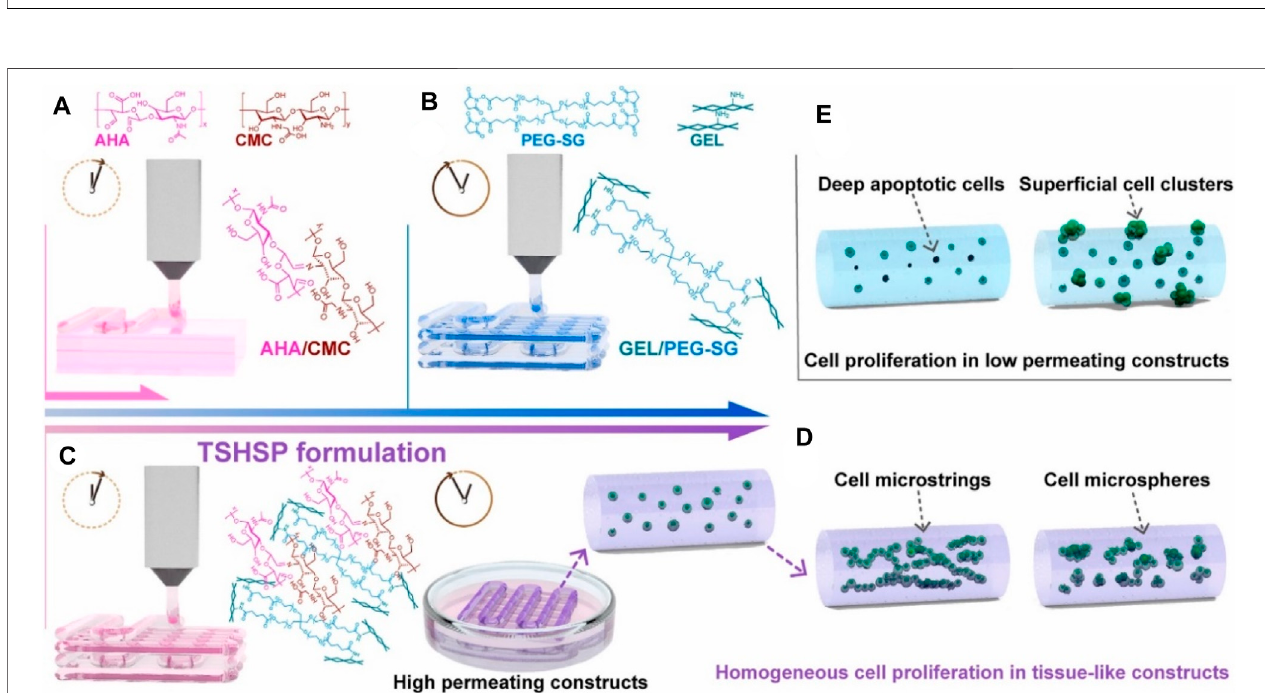
FIGURE 6 | Schematic representation of bioprinting TSHSP hydrogel constructs from AHA/CMC and GEL/PEG-SG. (A) Microstructure fusion of constructs. (B) Time-consuming pre-printing preparation. (C) TSHSP formulation by the complementarity of AHA/CMC and GEL/PEG-SG. (D) Uniform proliferation pattern of cells in tissue-like constructs. (E) Proliferation pattern ofcells in lowpermeating constructs. Reproduced from Chen et al., (2021) withpermissionfrom Copyright 2021 Elsevier.